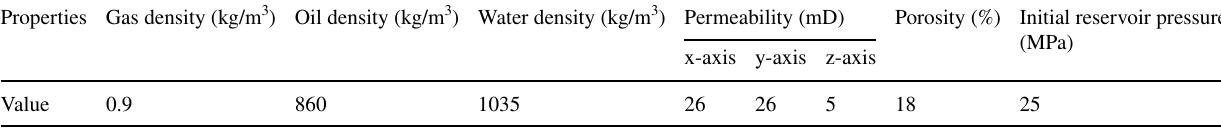
Table 3 The properties of the fluids and rock used in the